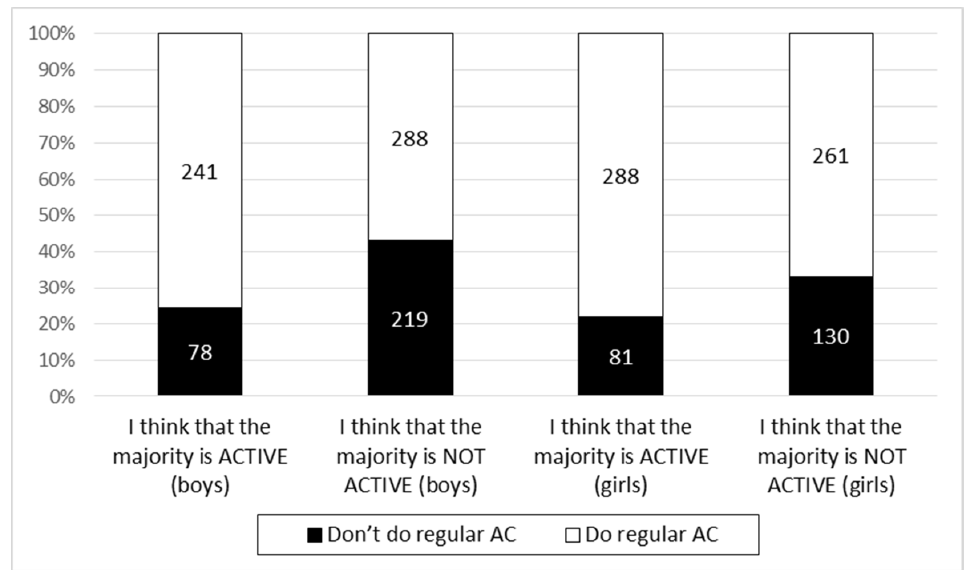
Figure 2. Absolute numbers of adolescents with/without regular AC to school by different perceived norms.